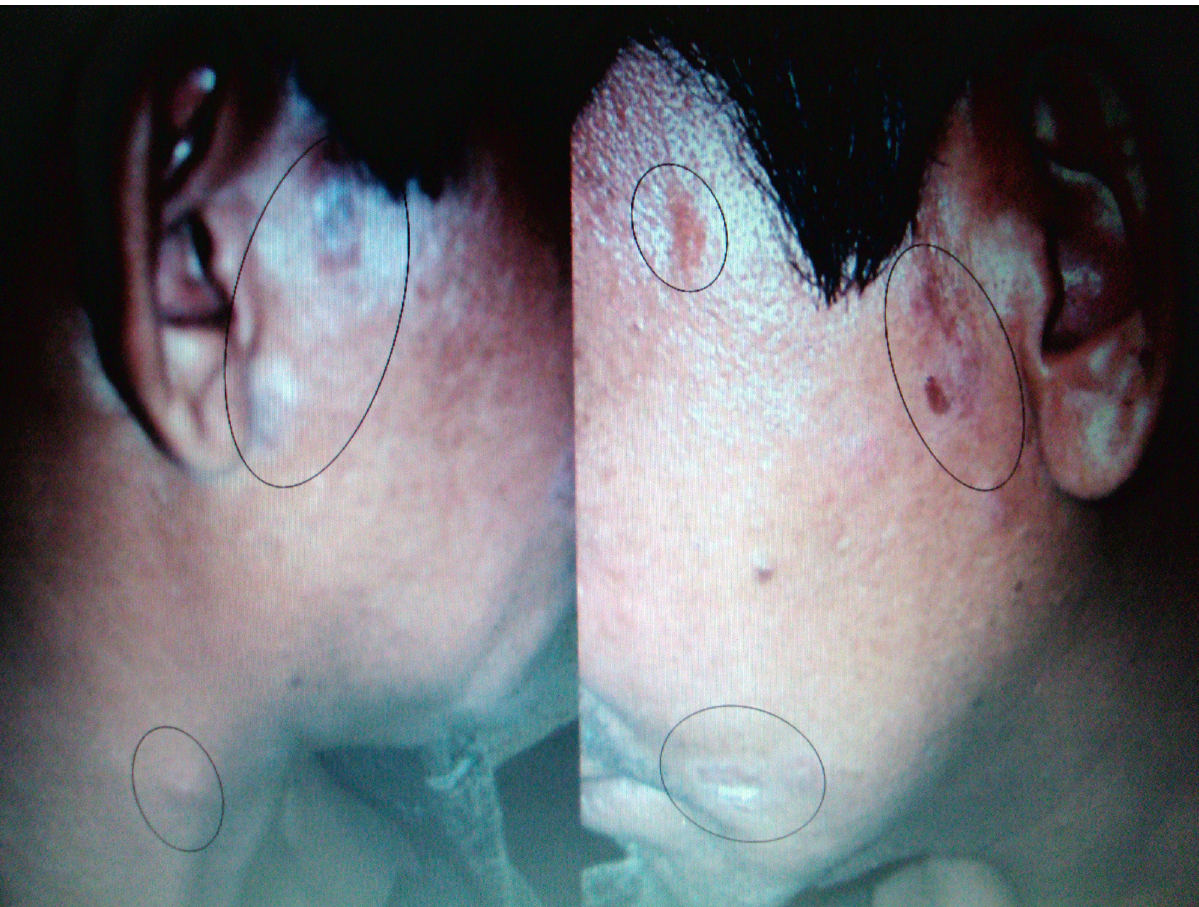
Figure 1. The patient showing papular lesions on pre-auricular regions and on the right cervical region, a scaly lesion on the left angle of the mouth and a pustular lesion on the